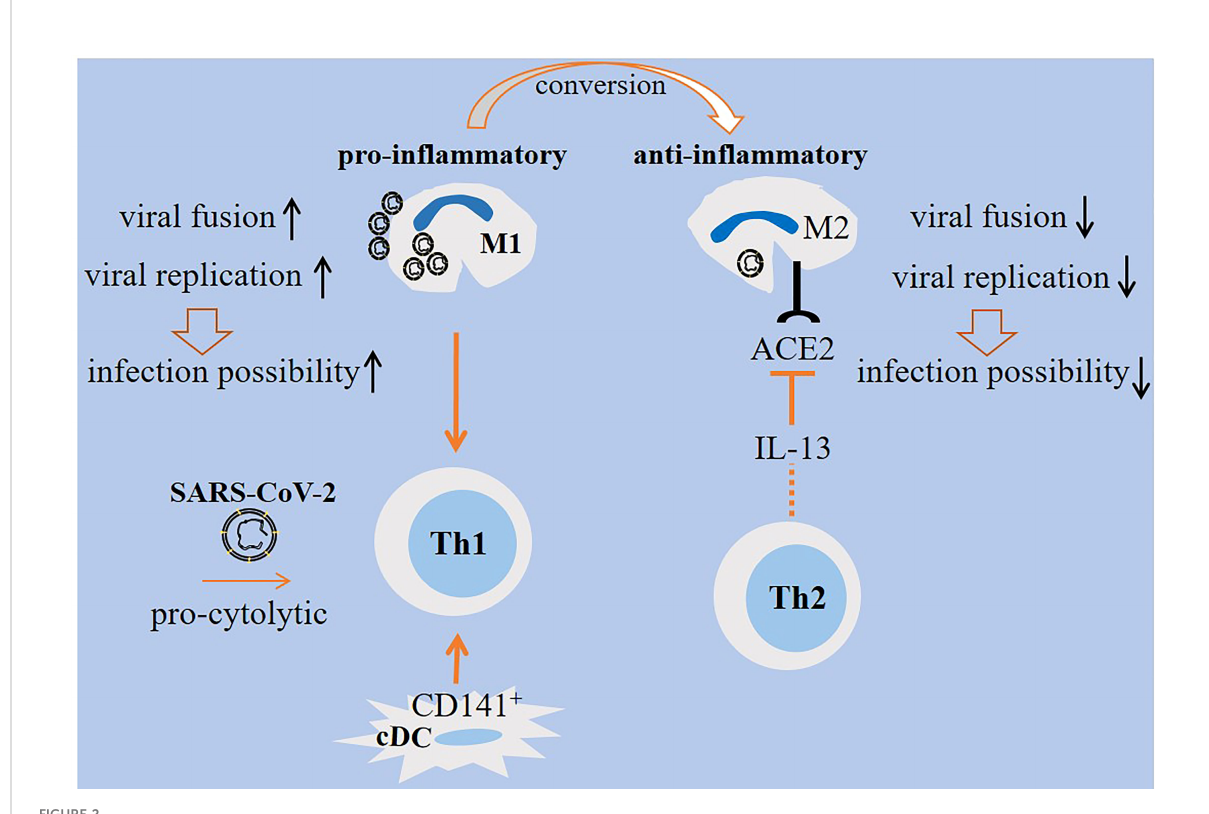
FIGURE 2 M1/M2 cellular states in SARS-CoV-2-induced disease. M1 macrophages are pro-in fl ammatory and are active during the early stage of viral entry, whereas M2 macrophages are anti-in fl ammatory that are active during late stages. Viral replication and fusion are high in M1 macrophages, whereas the rate of replication is low in M2 macrophages. Lower lysosomal pH favors more viral degradation in lysosomes of M2 macrophages. Therefore, M1 macrophages are more prone to viral load and lung infection. The expression of angiotensin-converting enzyme 2 (ACE2) on M2 macrophages is reduced by IL-13 released from T helper 2 (Th2) cells, which is indicative of a level of resistance among M2 macrophages. Th1 cells are induced by M1 macrophages. Th1 polarity with pro-cytolytic activity is also induced by severe SARS-CoV-2. A shift from M1- to M2-like phenotype is required for promoting resolution of in fl